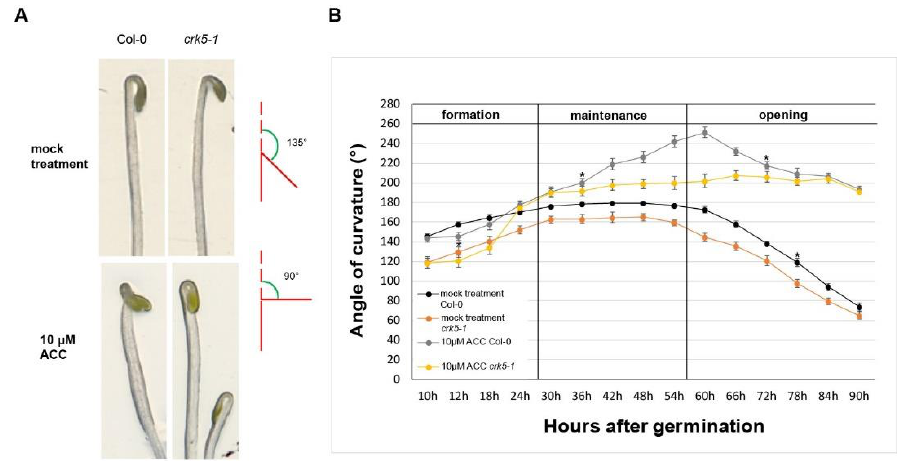
Figure 1. Hypocotyl hook phenotypes and kinetics of apical hook development of wild type (Col-0) and mutant (At crk5-1 ) seedlings during dark germination. ( A ) Hypocotyl hook phenotypes of 3-days-old dark-grown seedlings of the wild type (Col-0) and mutant (At crk5-1 ) in the absence and presence of 10 μM ACC. The wild-type seedlings had 180° hypocotyl hook bending, while the mutant seedlings displayed less hook bending capacity under normal conditions at 3 days after germination (during the hook maintenance phase). 10 μ M ACC increased the bending of wild-type hooks and restored that of the At crk5-1 mutant to app. 180°. The angle of hook curvature was determined by measuring the outer angle between the main axis of hypocotyl and curvature of cotyledons (see illustration). ( B ) Kinetics of apical hook development in Col-0 and At crk5-1 dark-grown seedlings in the absence and presence of ACC. Averages with standard errors are shown ( n = 35). Differences between the wild type and the mutant were statistically significant between the two indicated (*) time points (Student’s t -test: P < 0.01). Col-0 = At wild type Columbia-0 seedlings, At crk5-1 = mutant seedlings. Two independent experiments were carried out with the same results.